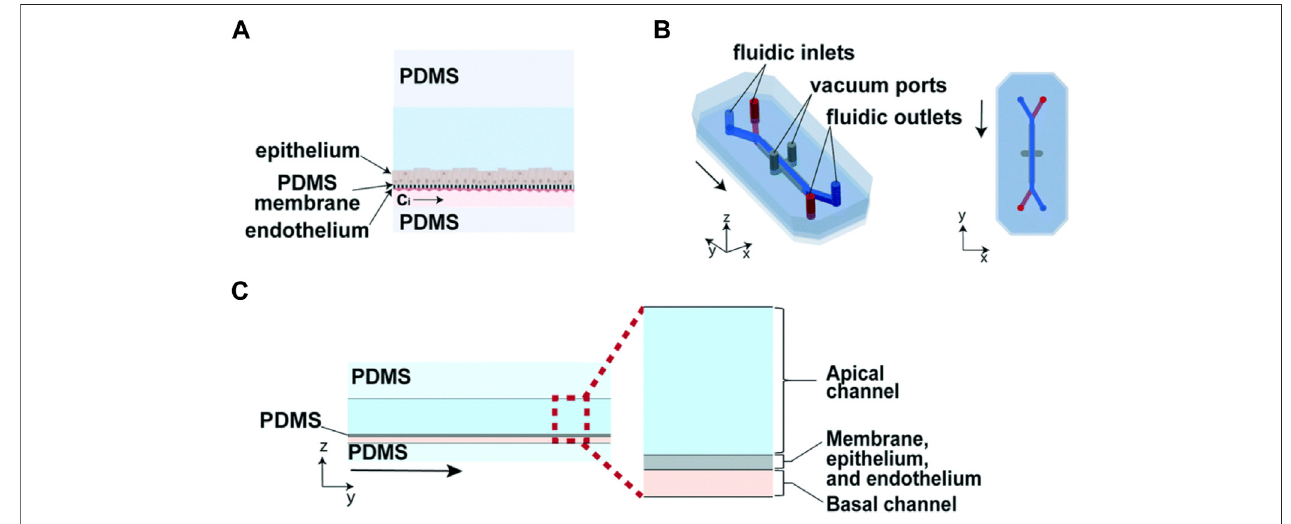
FIGURE9| Designofatwo-channelhumanlungairwayorganchip. (A) reconstructionoftheporousPDMS fi lm; (B) theillustrationofthelungairwayorganchip; (C) the side view of the construction of organ chip (Grant et al., 2021).